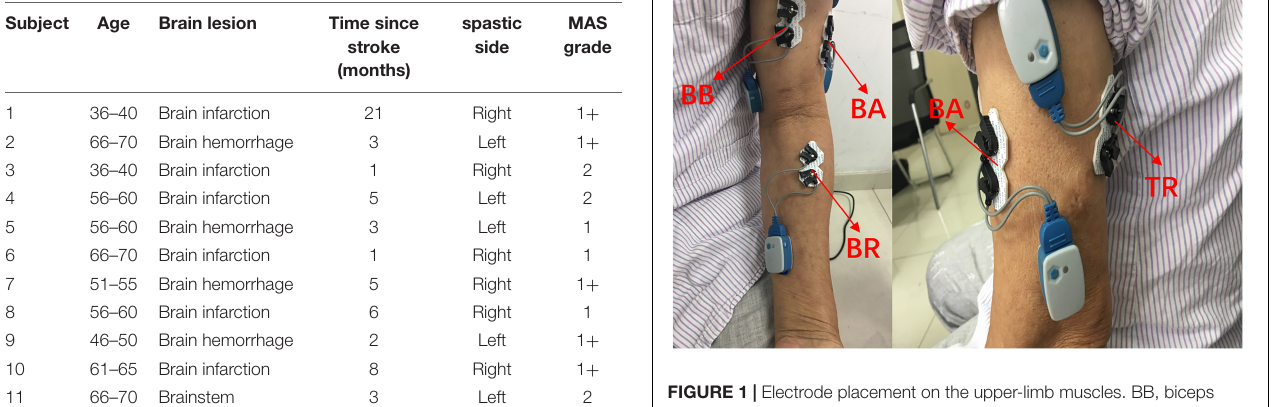
FIGURE 1 | Electrode placement on the upper-limb muscles. BB, biceps brachialis; TB, triceps brachialis; BR, brachioradialis; BA,